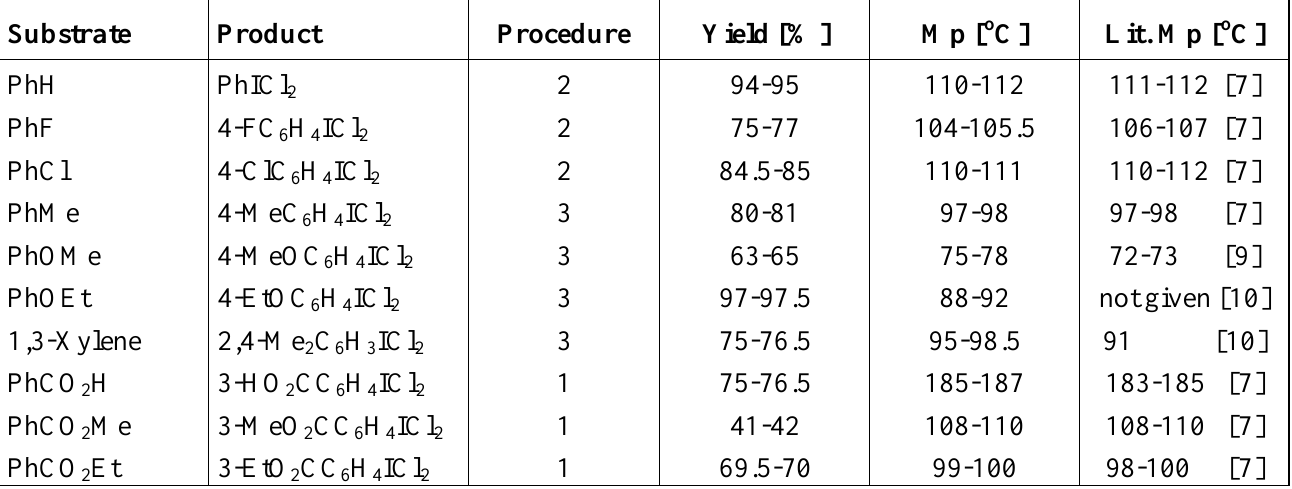
Table 1 . Preparative Details, Yields, and Melting Points ( with decomposition ) of